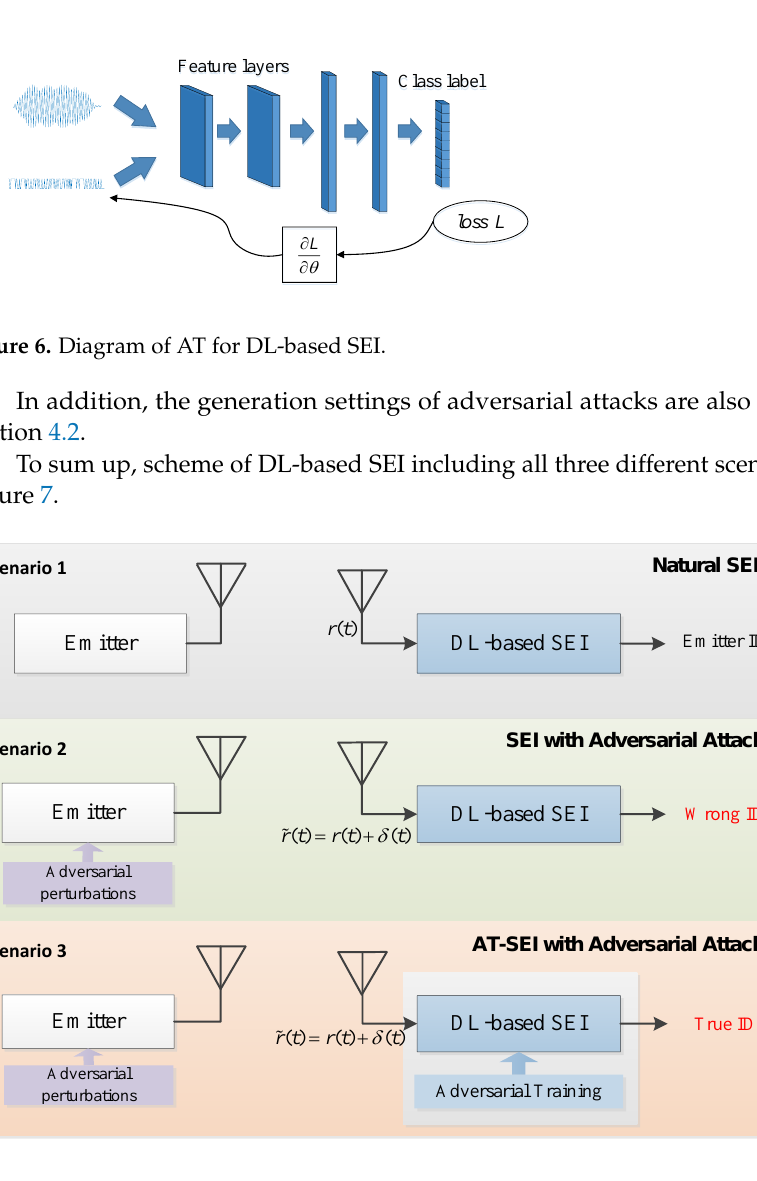
Figure 7. Scheme of DL-based SEI in three different